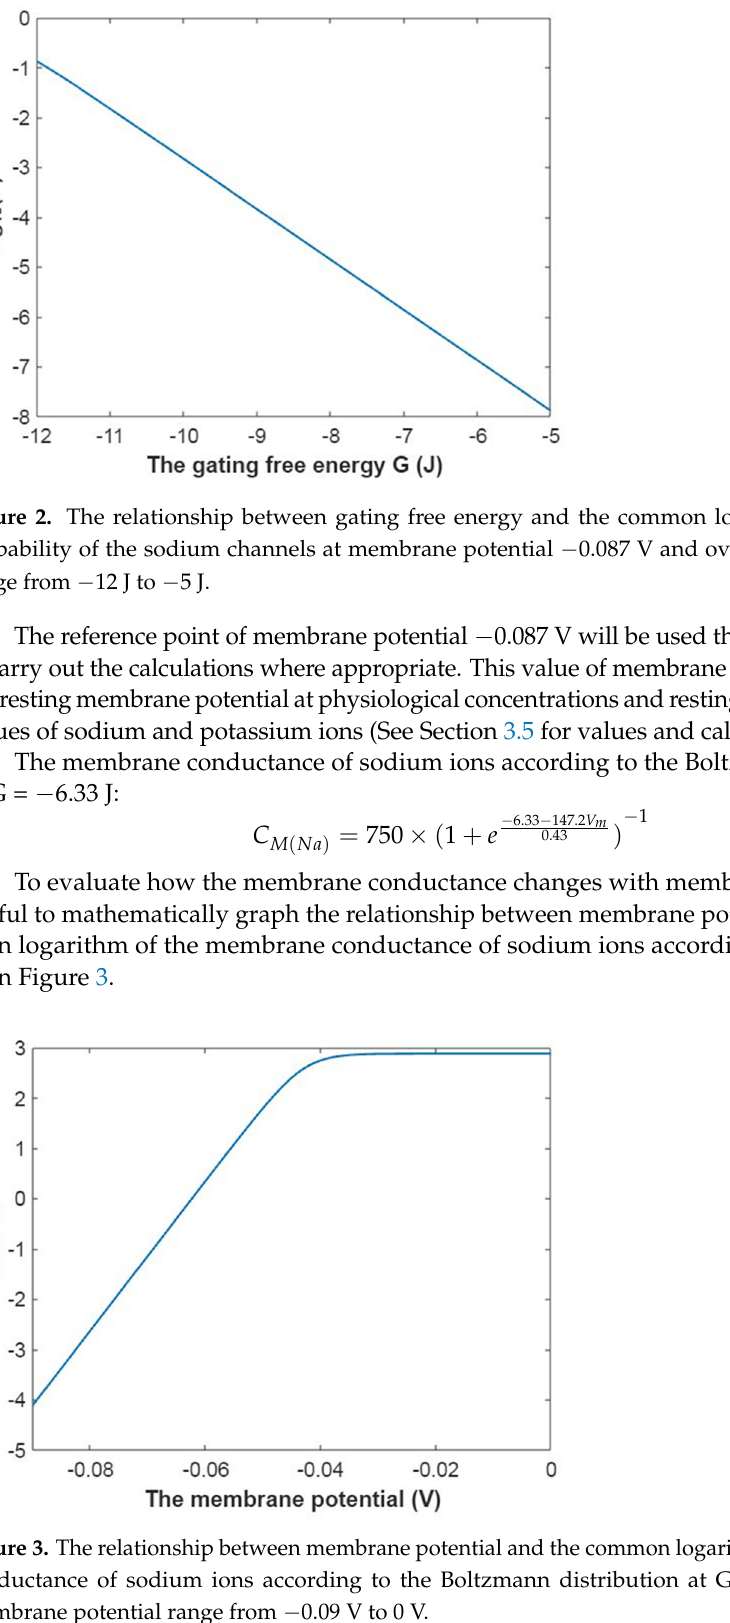
122 Figure 1. The relationship between the membrane potential and the common logarithm of the open probability of sodium channels at G = − 6.33 J and over membrane potential range from − 0.09 V to 0 V. The open probability of sodium channels at membrane potential − 0.087 V: